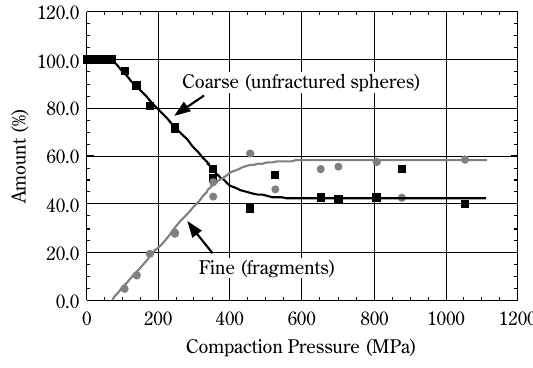
Fig. 8 As compaction pressure is increased, the amount of unfrac- tured spheres decreases as fragments are formed, but reaches a constant value of about 40% at high